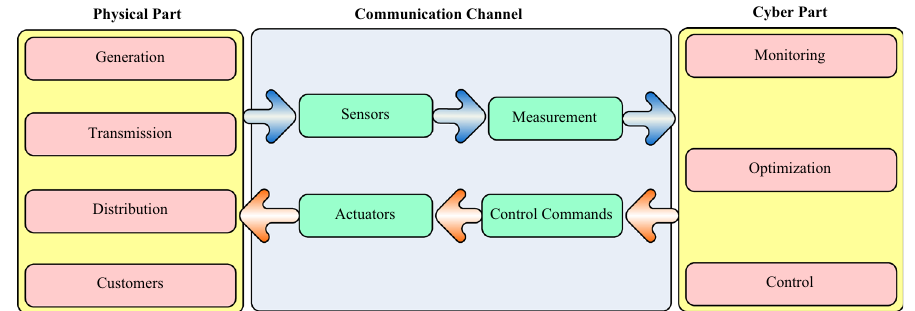
Fig. 9 Cyber-physical structure of smart grid